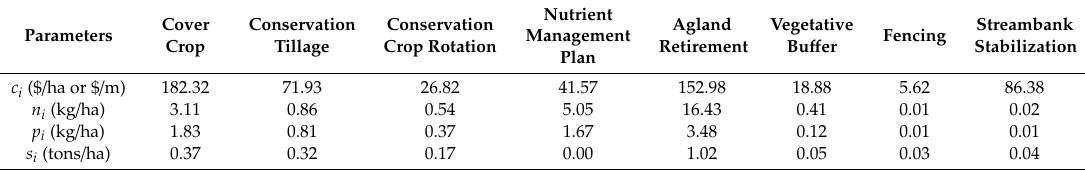
Table 2. Objective function coe ffi cients ( c i ) and technical coe ffi cients ( n i , p i , s i ) used in the optimization model (Normal weather scenario).